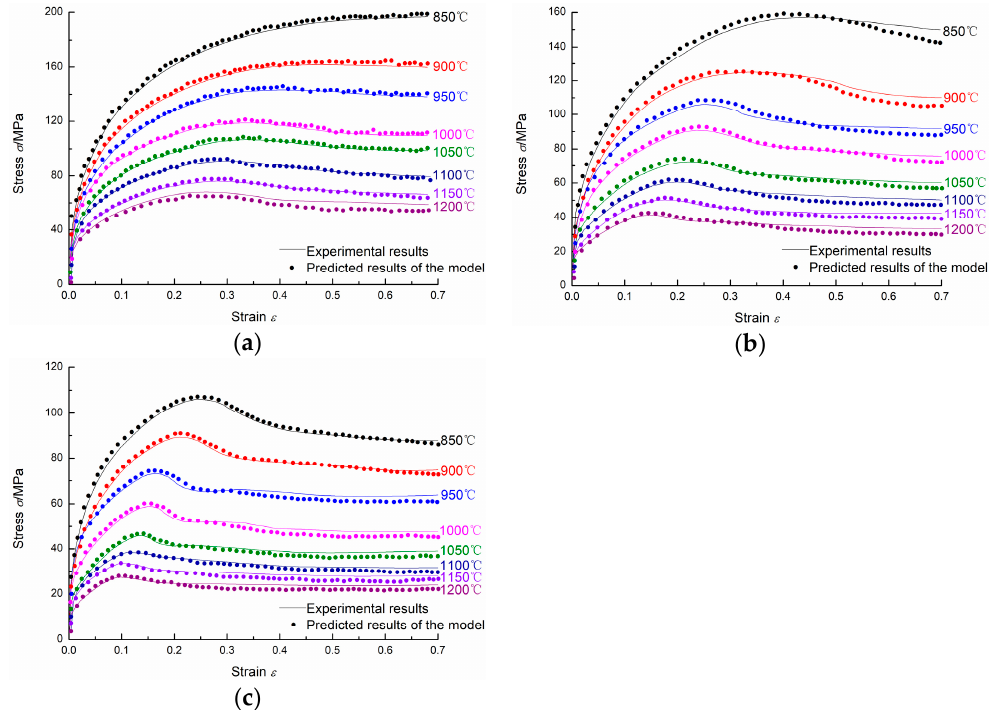
Figure 15. The comparison between experimental results and predicted results of the model: ( a ) 1/s; ( b ) 0.1/s; ( c ) 0.01/s.